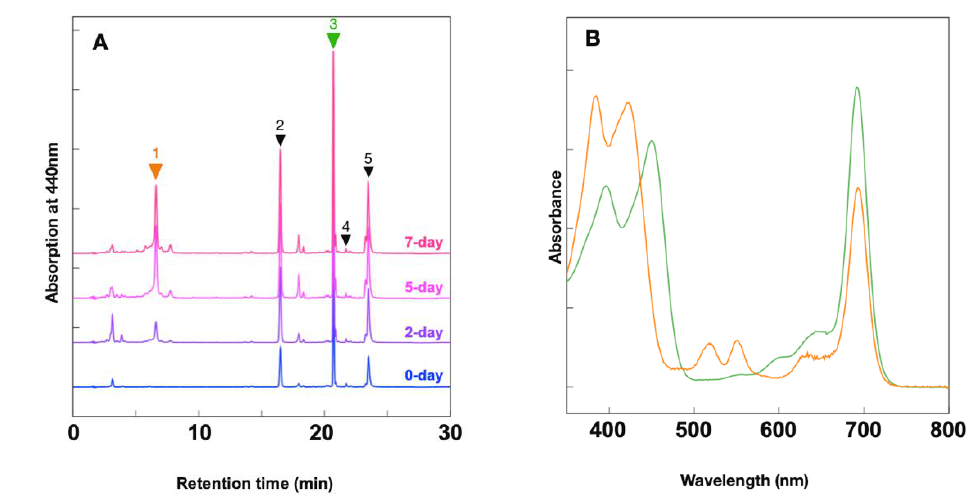
Figure 5. Accumulation of Chl d -like pigment in anoxic and dark conditions. ( A ) Total pigment was extracted from A. marina cells grown under anoxic and dark conditions at 0 (blue), 2 (purple), 5 (pale violet), 7-day (pink), respectively. The total pigments were separated by C8 column monitored by absorption at 440 nm. Each arrows indicate Chl d -like pigment (1), zeaxanthin (2), Chl d (3), Chl a (4), and α -carotene (5), respectively. ( B ) In-line absorption spectra of Chl d (green) and Chl d -like pigment (orange).